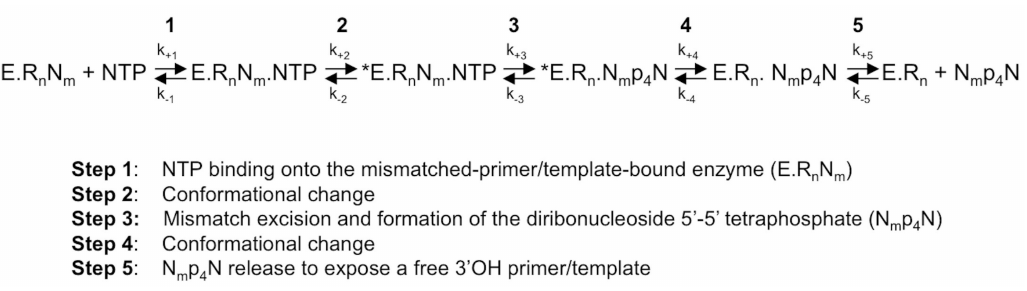
Figure 2. The NTP-mediated nucleotide excision pathway by HCV RdRp [30]. A mismatched 3 (cid:48) -end nucleotide is excised by a pyrophosphorolysis-like reaction, in which the pyrophosphate donor comes from an undefined NTP of the intracellular nucleotide pool. E, enzyme; R n N m : primer annealed to the template with a 3 (cid:48) -terminal mismatch; R n : perfectly matched doubled-stranded RNA; *E: catalytically competent enzyme; NTP: correct (i.e., template-complementary) NTP; N m p 4 N: diribonucleoside 5 (cid:48) -5 (cid:48) tetraphosphate made of the 3 (cid:48) -base of mismatched nucleoside N m linked by a 5 (cid:48) -tetraphosphate-5 (cid:48) bridge to a nucleoside coming from the intracellular nucleotide